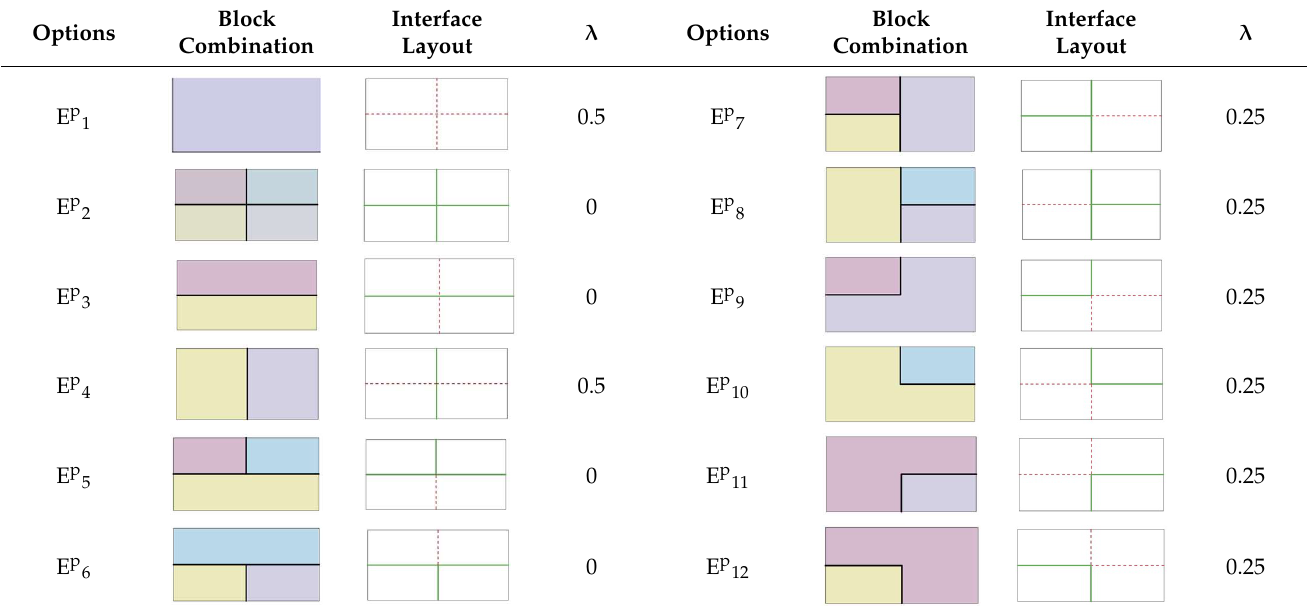
Table 1. Computed load factors for twelve configurations of the segmental models with no-tension material.